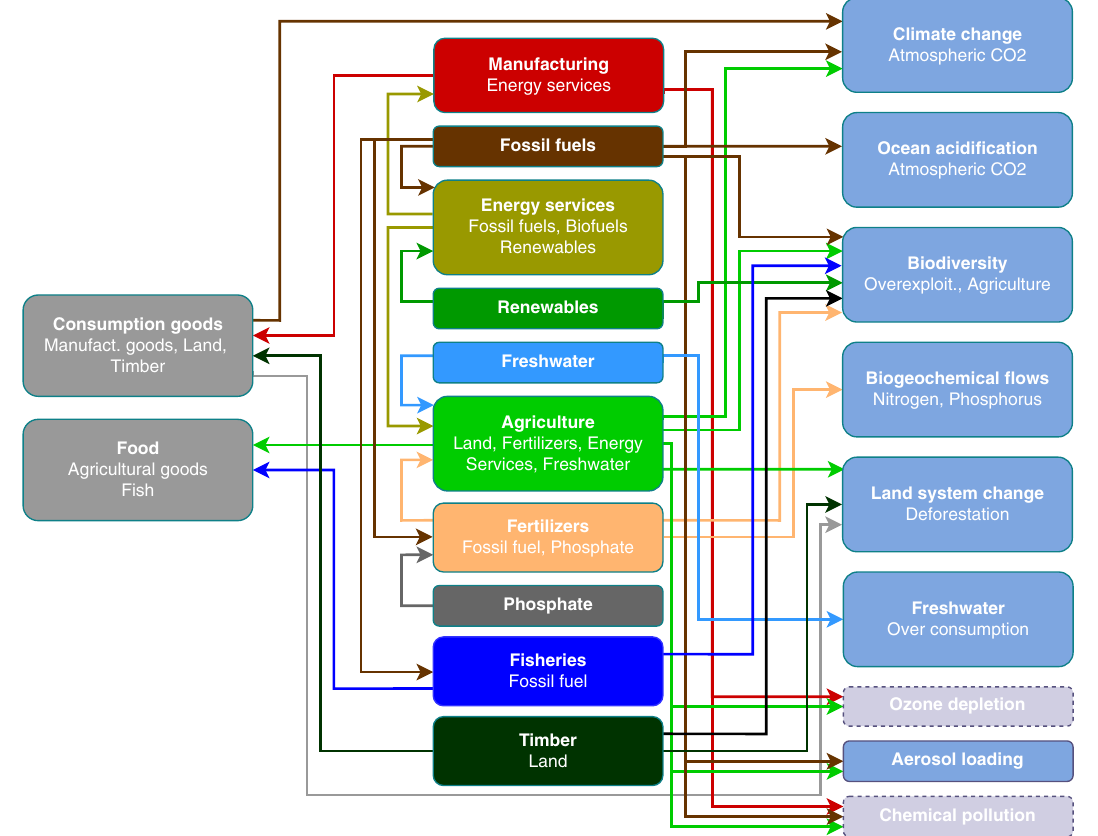
Fig. 1 Schematic of the integrated economic-planetary boundaries model. The above schematic gives an overview of the direct links existing in the model. The model is built in three layers (columns): consumption, production, and ESPs. The arrows indicate the direction of the economic inputs and outputs and which planetary processes they have an impact on. With the exception of ozone depletion and chemical pollution the impact of the two policy scenarios we consider are quantitatively